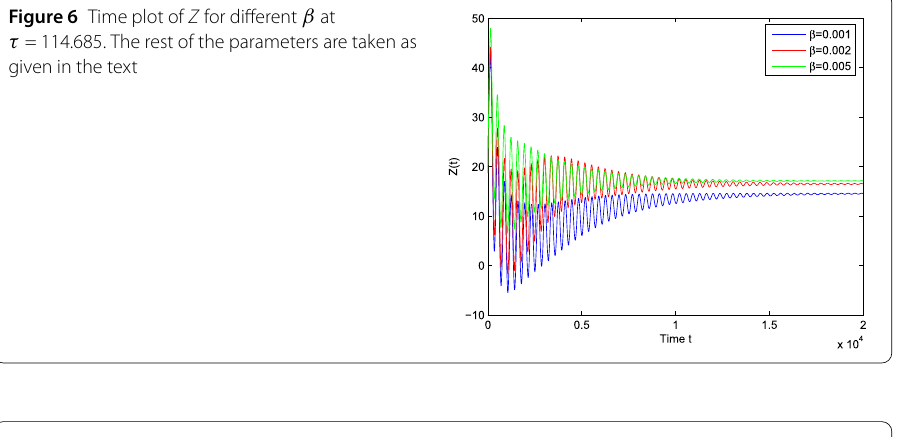
Figure 7 Time plot of Z for different η at τ = 114.685. The rest of the parameters are taken as given in the text